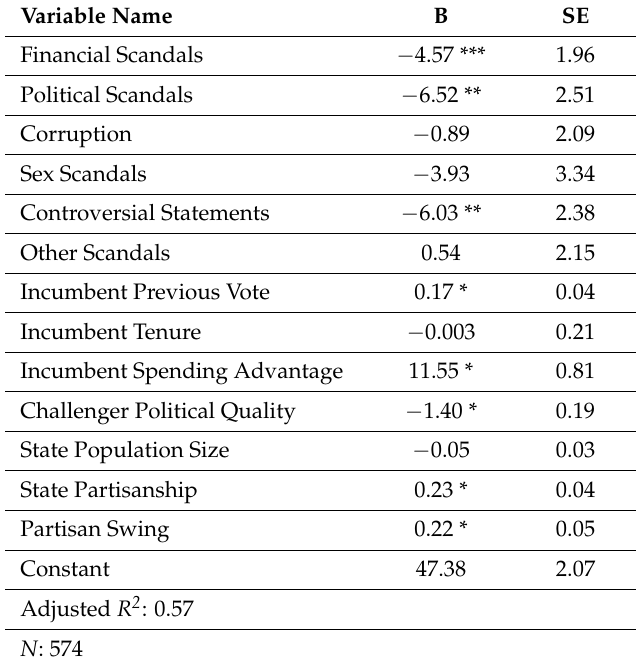
Table 6. The impact of types of scandals on incumbent vote share,